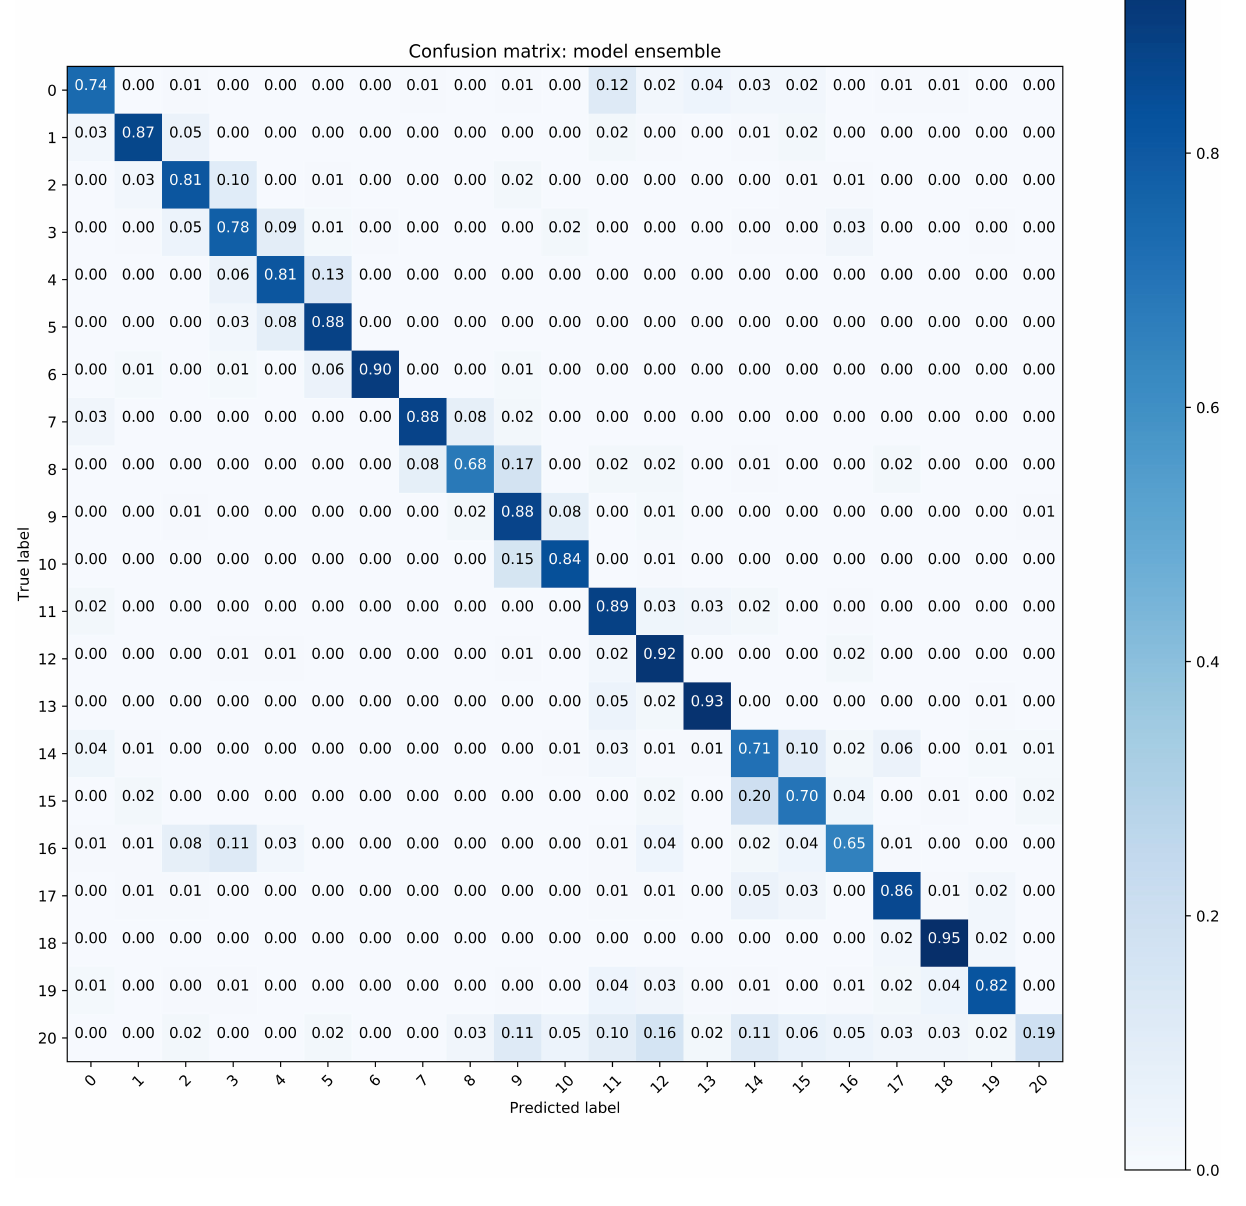
cells is over 90.00% (27). There are also other studies that